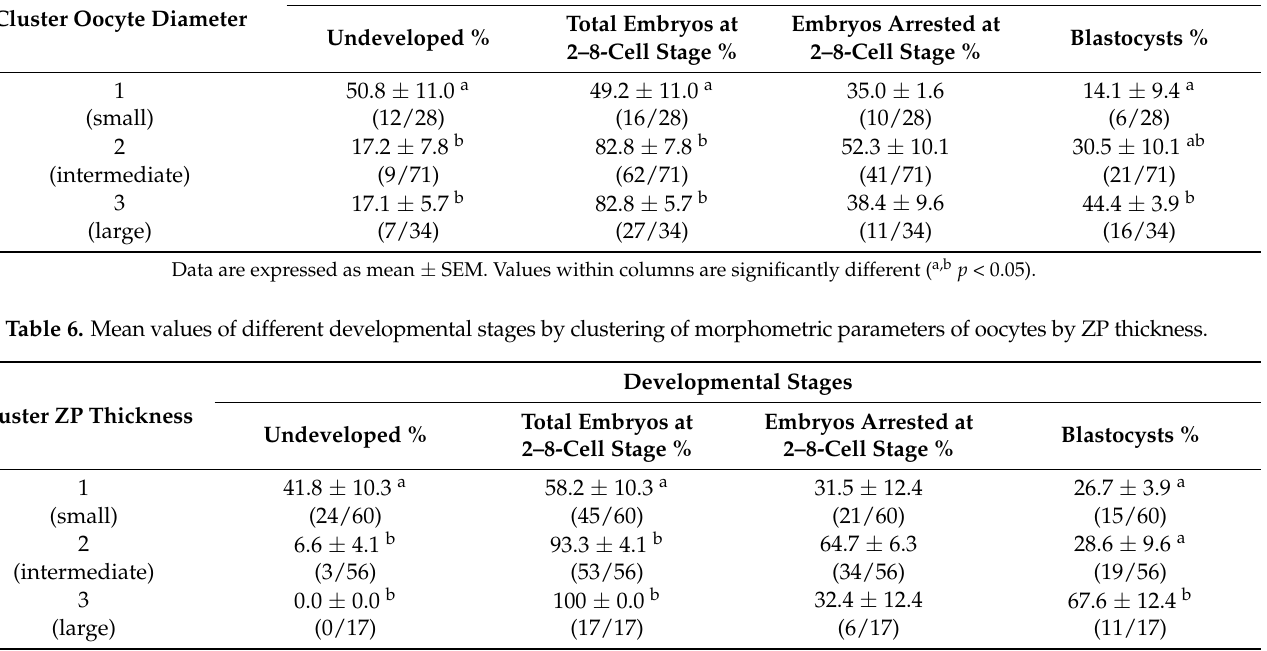
Cluster Oocyte Diameter